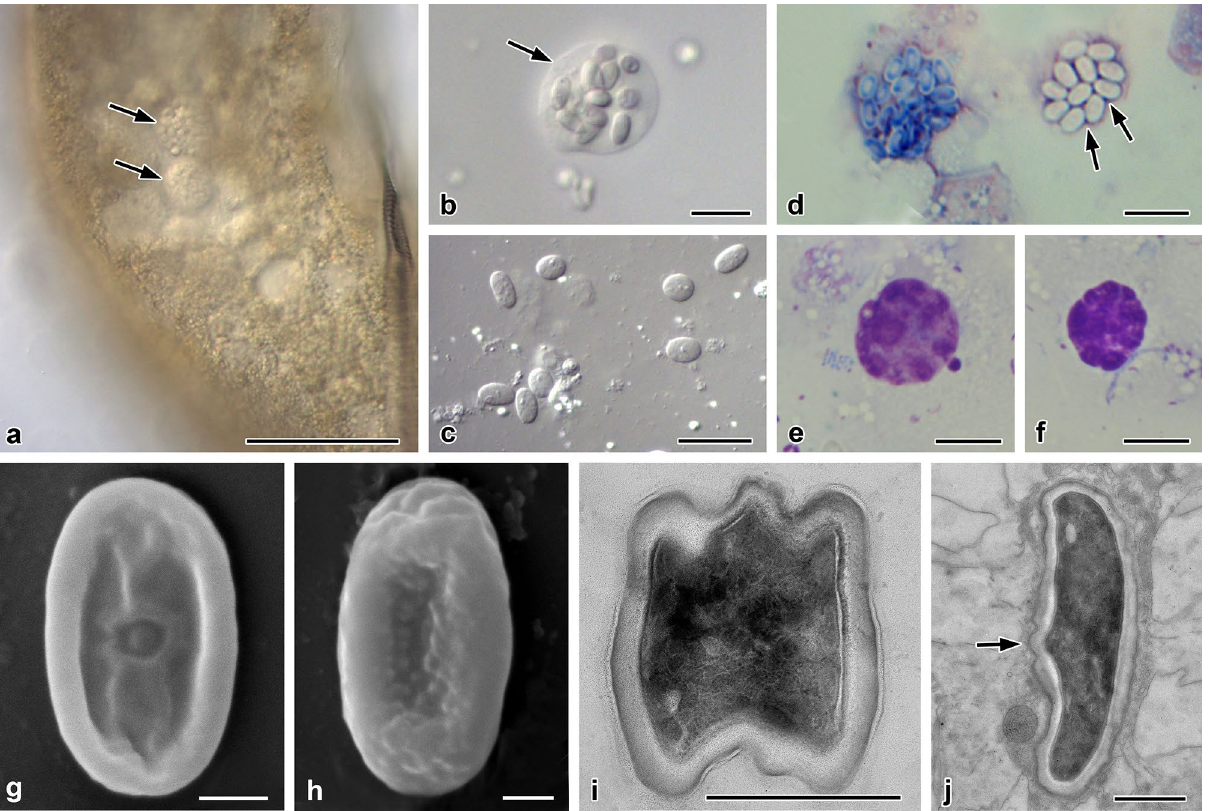
Figure 1. Nephridiophaga postici sp. nov. from Eublaberus posticus . ( a ) Infected Malpighian tubule containing sporogenic plasmodia (arrows). ( b ) Sporogenic plasmodium. Arrow points to plasma membrane of plasmodium. ( c ) Single spores. ( d – f ) Giemsa staining. ( d ) Left plasmodium with sporoblasts, right with mature spores. Arrows point to vegetative nuclei. ( e , f ) Vegetative plasmodia with stained nuclei. ( g , h ) Scanning electron micrographs of dorsal ( g ) and ventral ( h ) side of flattened, mature spores. ( i , j ) Ultra-thin sections. ( i ) Mature spore in cross-section. ( j ) Mature spore in longitudinal section. Arrow points to region of spore opening. Multilayered spore wall. Scale bars: (a) = 50 µm, (b–f) = 10 µm, (g–j) = 1